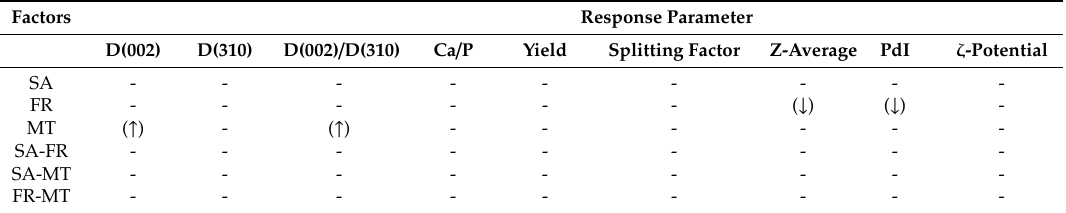
Table 5. Summary of process factors and their significance on CaP NPs’ physico-chemical properties. The arrows indicate whether an increase in the factor leads to an increase ( ↑ ) or a decrease ( ↓ ) in the physico-chemical properties.